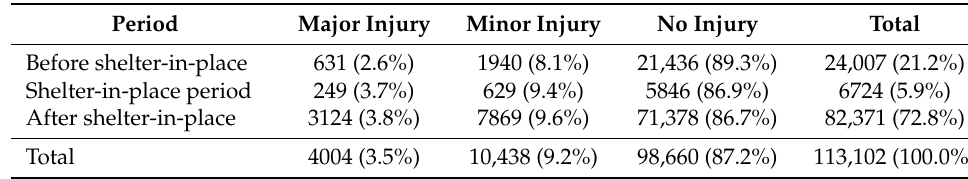
Table 1. Distribution of crashes by injury outcomes.